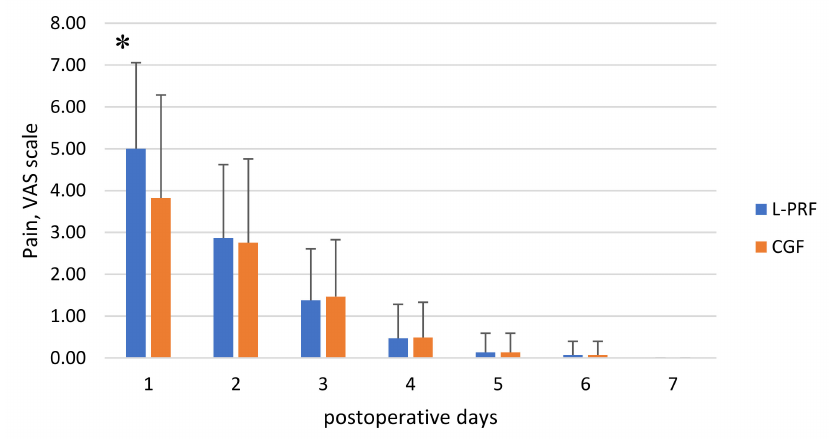
Figure 3. Post-operative pain assessment. Patients of the Concentrated Growth Factors (CGF) group reported significantly less pain in the first day postsurgery